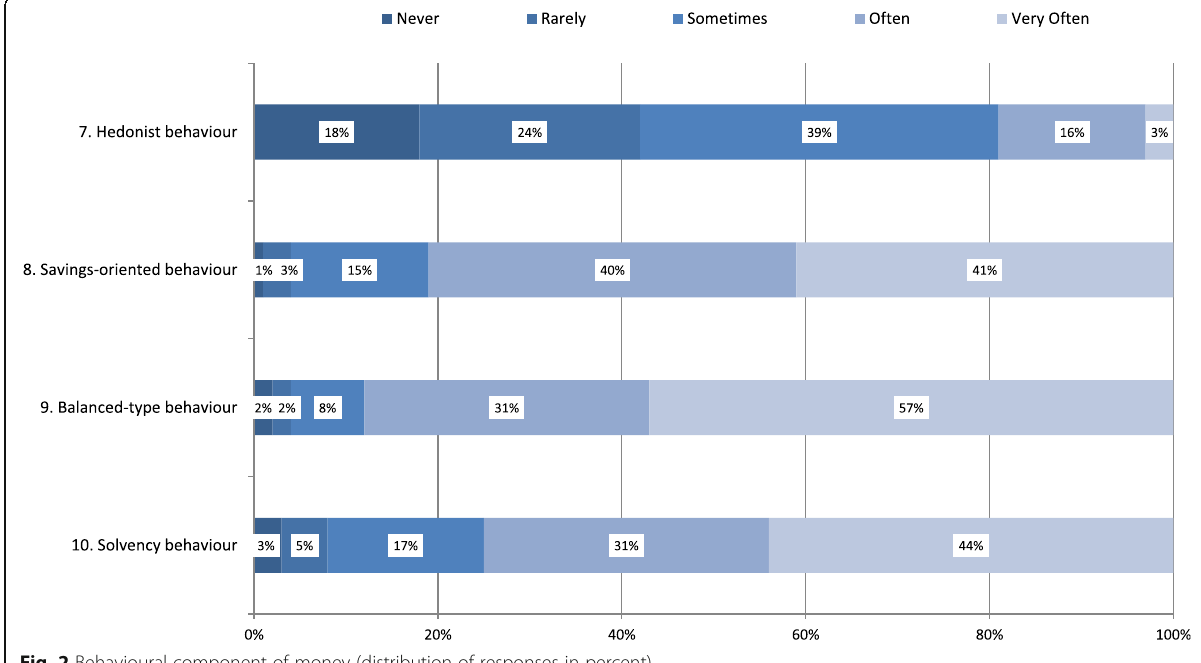
Fig. 2 Behavioural component of money (distribution of responses in